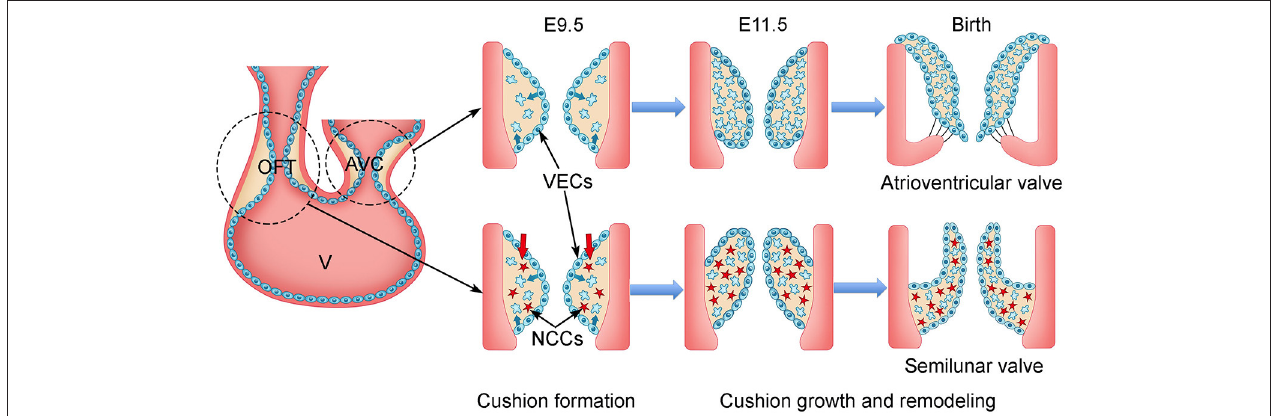
FIGURE 1 | Schematic of cardiac valve development in mice. During mouse embryogenesis, the linear heart tube, composed of outer layer of myocardium (orange) and inner layer of endocardium (blue), undergoes looping beginning at E8.0. The process divides the heart tube into four segments: the atrium, atrioventricular canal (AVC), ventricle (v), and outflow tract (OFT) by E9.5. Two matrix-rich and acellular tissue swellings, named endocardial cushions, are formed within the AVC and OFT regions. In response to the signals from the myocardium, the endocardial cells within the AVC and proximal OFT regions undergo endocardial-to-mesenchymal transformation (EMT). The transformed mesenchymal cells invade the matrix-rich cardiac jelly and proliferate to populate the endocardial cushions within the proximal OFT, while the cardiac neural crest cells (NCCs) migrate into the distal OFT. By E11.5, the AVC and OFT cushions are fully cellularized. After E11.5, the AVC and OFT cushions grow rapidly and undergo intensive remodeling involving spatiotemporal cell proliferation and apoptosis of valve interstitial cells (VICs), as well as dynamic extracellular matrix (ECM) arrangement. The AVC and OFT cushions eventually give rise to the atrioventricular valves (mitral and tricuspid valve) and semilunar valves (aortic and pulmonary valve), respectively. VECs, valve endocardial